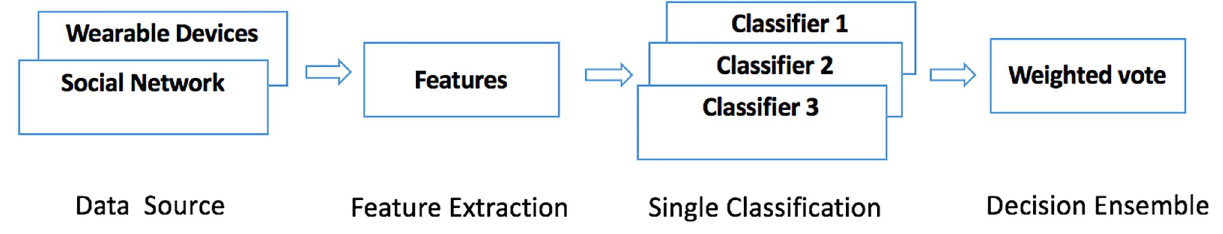
Fig 4. A network-driven prediction method,